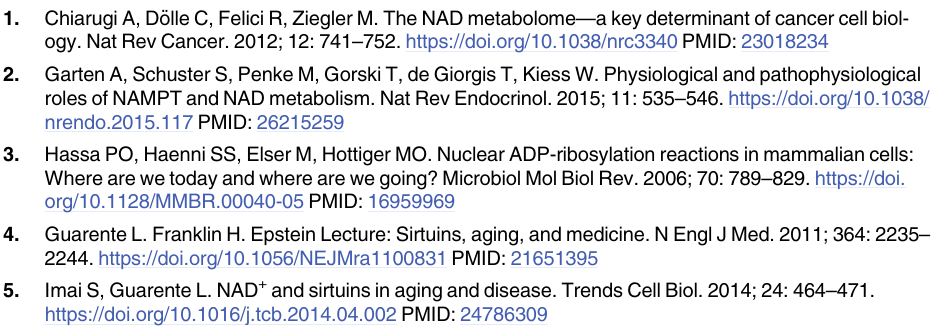
S1 Table. Parameters for SRM analysis of NAD + and Nam with API3000. DP, declustering potential; FP, focusing potential; CE, collision energy; CXP, collision cell exit potential; RT, retention time; LOQ, limit of quantification. Data indicated by asterisks are from Yamada K, Hara N, Shibata T, Osago H, Tsuchiya M. (2006) The simultaneous measurement of nicotin- amide adenine dinucleotide and related compounds by liquid chromatography/electrospray ionization tandem mass spectrometry. Anal Biochem 352:282–285. S2 Table. Parameters for SRM analysis of NAD + and Nam with LCMS-8030. CE, collision energy; RT, retention